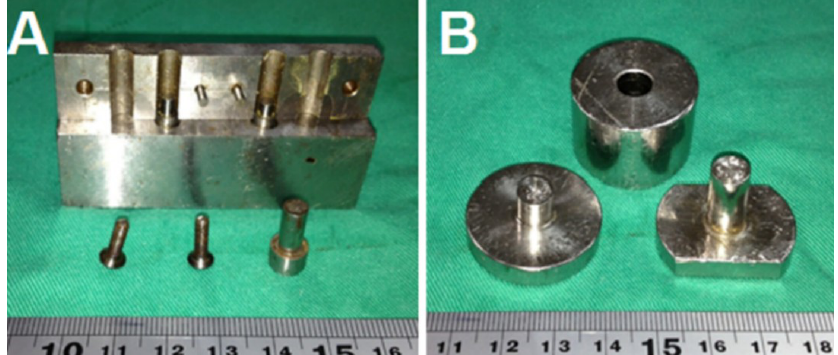
Figure 1. Molds with diameters of ( A ) 1 mm and ( B ) 8 mm. (Diameters of 5, 8 and 10 mm molds have the same geometric view.)